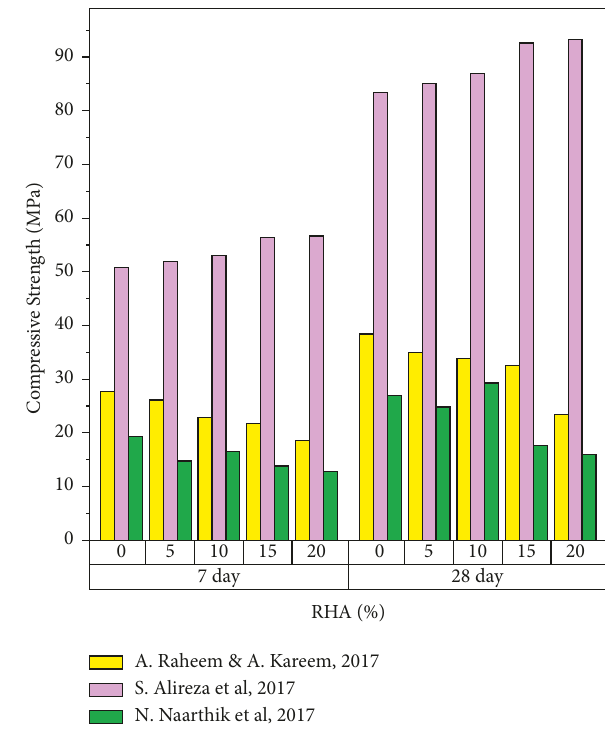
Figure 22: Compressive strength of concrete containing